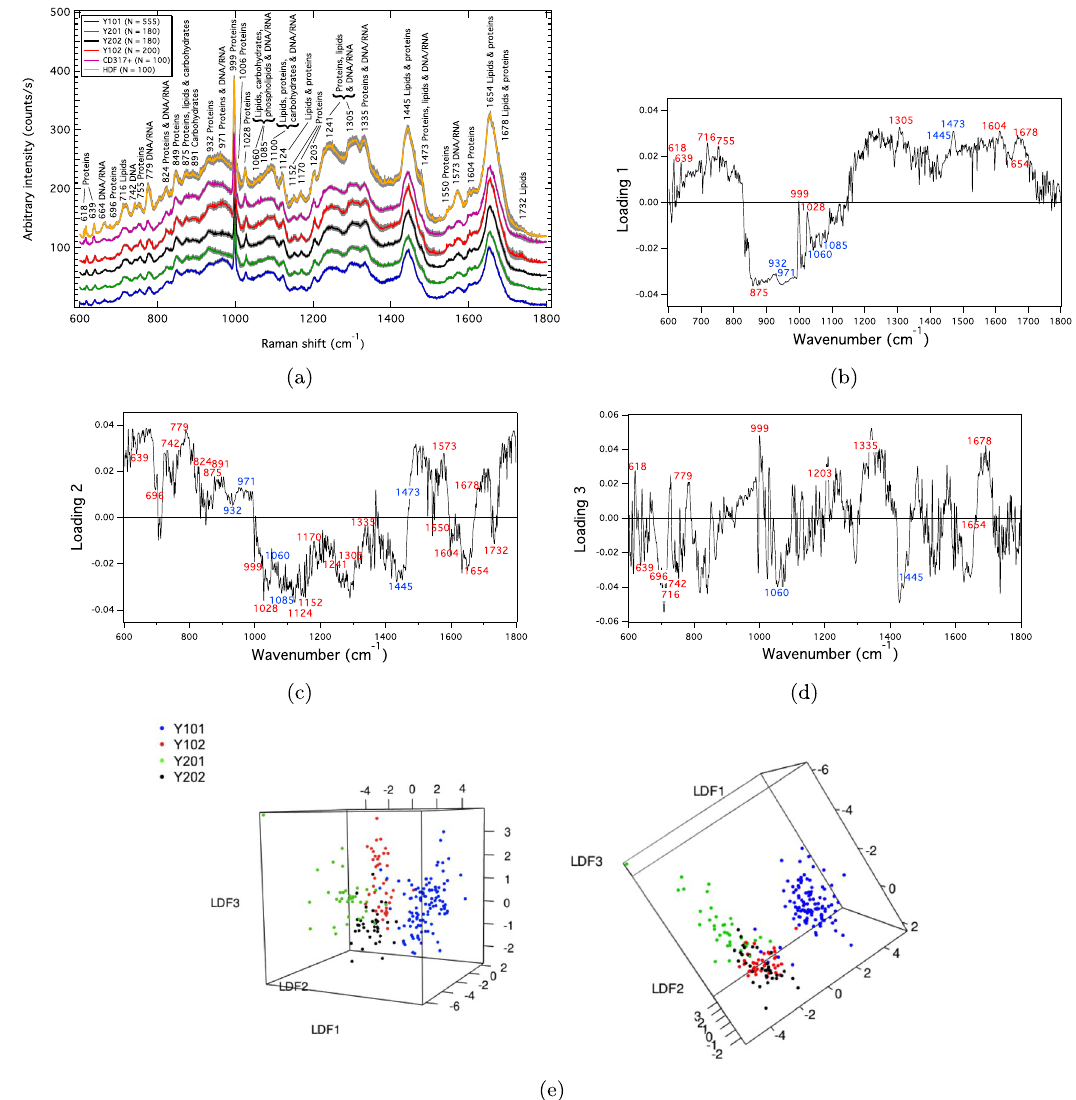
Figure 1. ( a ) Averaged Raman spectra obtained from the cell nuclei of the four hTERT MSCs, primary − 1 CD317+MSCs, and HDF cell-populations in the ‘fingerprint’ region (600–1800 cm ), where N is the total number of individual spectra in each spectral average. The SE envelopes associated with each spectrum are shown in grey. Peak positions were averaged across the hTERT MSCs giving the representative values in the figure. Table S2 shows the peak-position ranges for all of the cell types studied in this work, with detailed − 1 biomolecular peak-assignments given in Table S3. The spectral resolution was ± 3 cm . PCA loadings corresponding to the ( b ) PC1, ( c ) PC2 and ( d ) PC3 principal components across the four hTERT MSC- types (cf. Fig. S8), which capture 32%, 22% and 12% of the total variance, respectively. Key points of variance above the background in the PC1 loadings correspond to visual differences seen in the average spectra in ( a ). Univariate analyses involving peak intensity ratios (PIRs) will show that the bands identified in blue have specific discriminatory capabilities. ( e ) PCA-LDA scatterplots for the hTERT MSCs generated by capturing 91% of the PCA variance. Cell-line discrimination using the first three linear discriminant functions (LDFs) is shown. An 84% overall prediction accuracy in determining the hTERT cell-types from these results was achieved using leave-one-out intensity ratio (PIR) analyses. By assessing all-peaks-against-all-peaks in each average hTERT MSC spectrum (Fig. 1a), the PIRs that separate the Y101/Y201 and Y102/Y202 groups, as well as fully discriminate the cell lines, were identified (Fig. 2). Here, ‘fully discriminate’ means complete separation of the PIRs for each MSC-type outside of the SE uncertainties (error bars). Discriminatory PIR profiles for the biologically-well-defined hTERT MSCs provide sets of panels against which other cell types can be compared. PIRs that fully discriminate the cell lines correspond to proteins, 639/932 − 1 (Fig. 2a), as well as those relative to the 971 cm band (proteins and DNA/RNA) (Fig. 2b, and also 971/1085 and